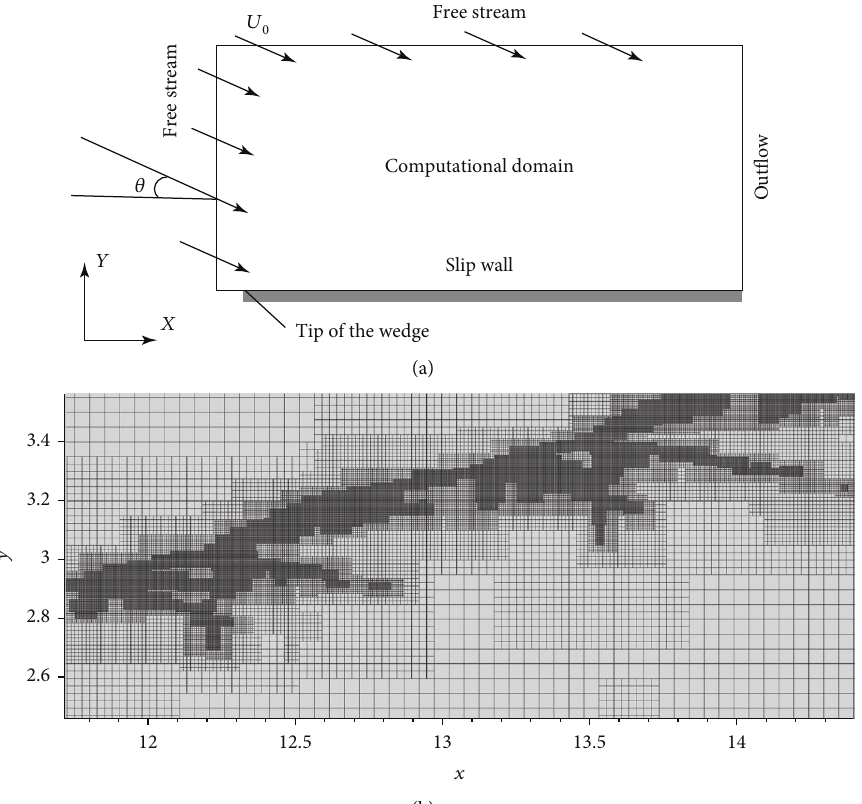
Figure 1: Schematic of the computational domain, boundary conditions, and adaptive meshes structure. (a) Computational model. (b) Five levels of adaptive